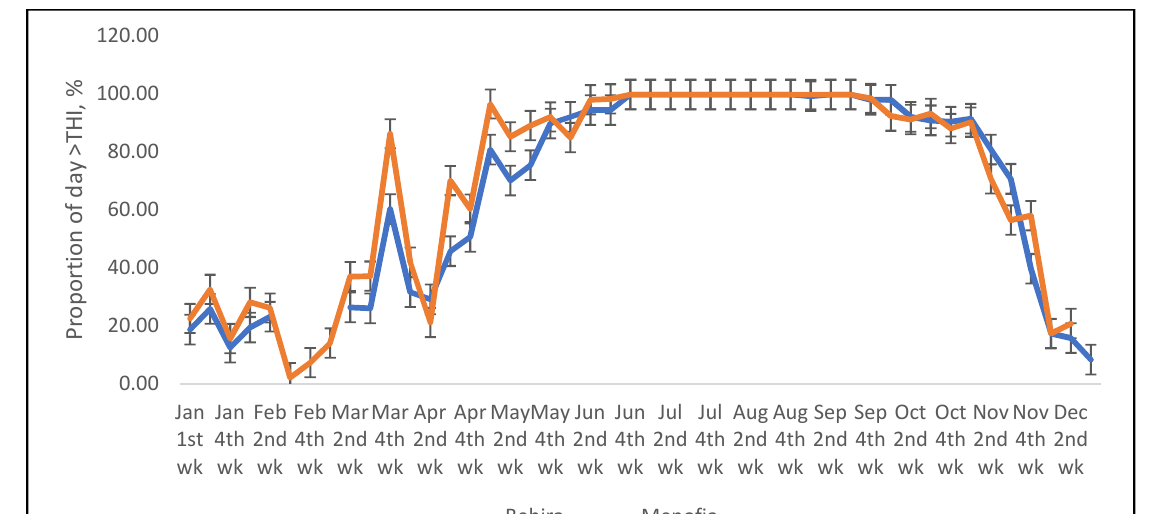
Figure 2 The proportion of half-hour periods in the day that cattle at the two locations (Behira and Menofia) in 2021 experienced THI greater than that believed to cause heat stress.